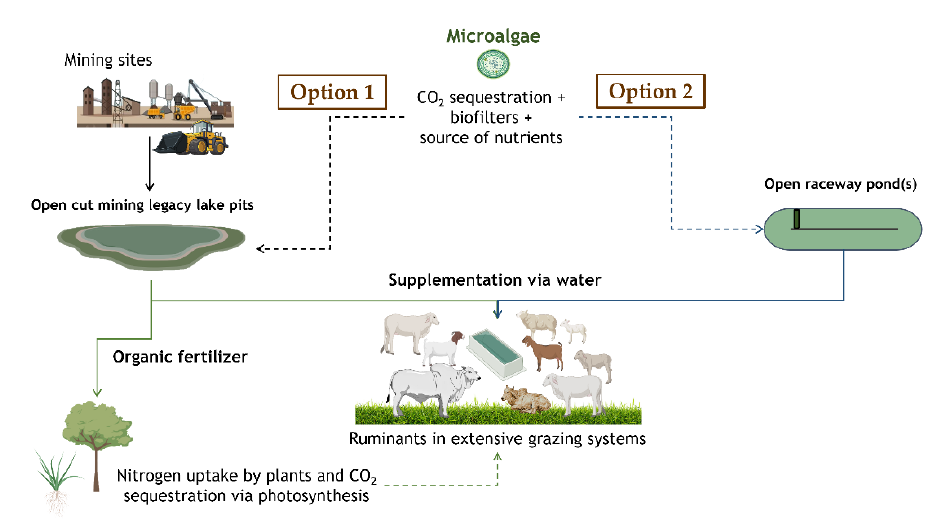
Figure 1. Hypothetical opportunistic on-farm production and water delivery feeding systems.